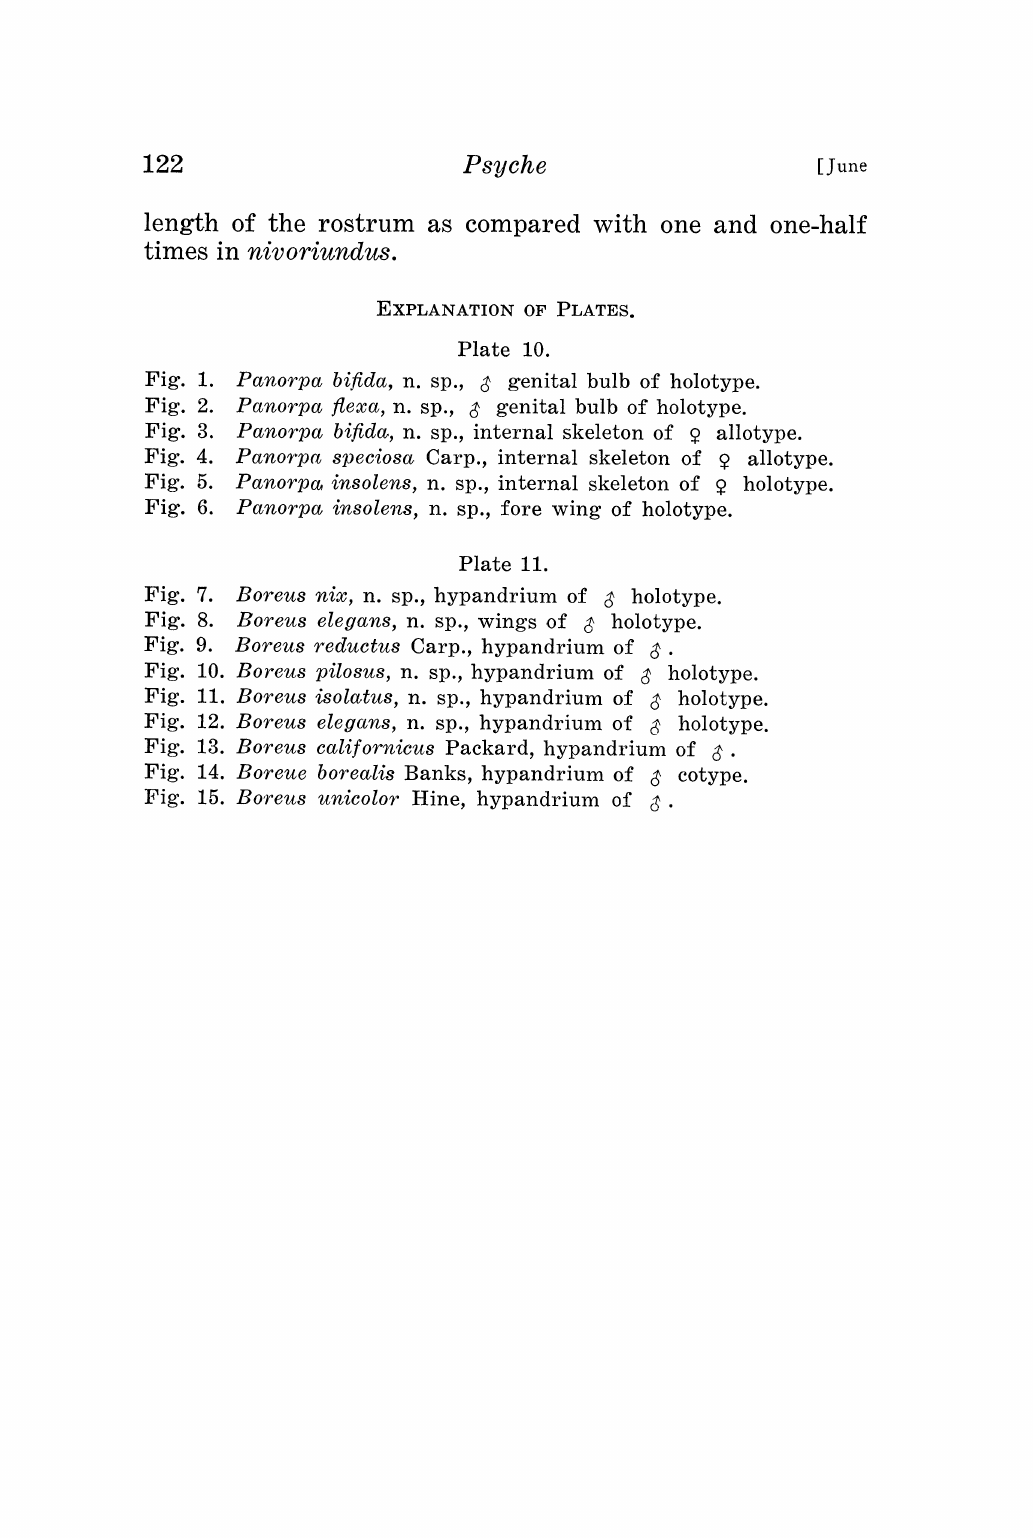
EXPLANATION OF PLATES. Plate 10. allotype. Panorpa speciosa Carp., internal skeleton of allotype. Panorp insolens, n. sp., internal skeleton of